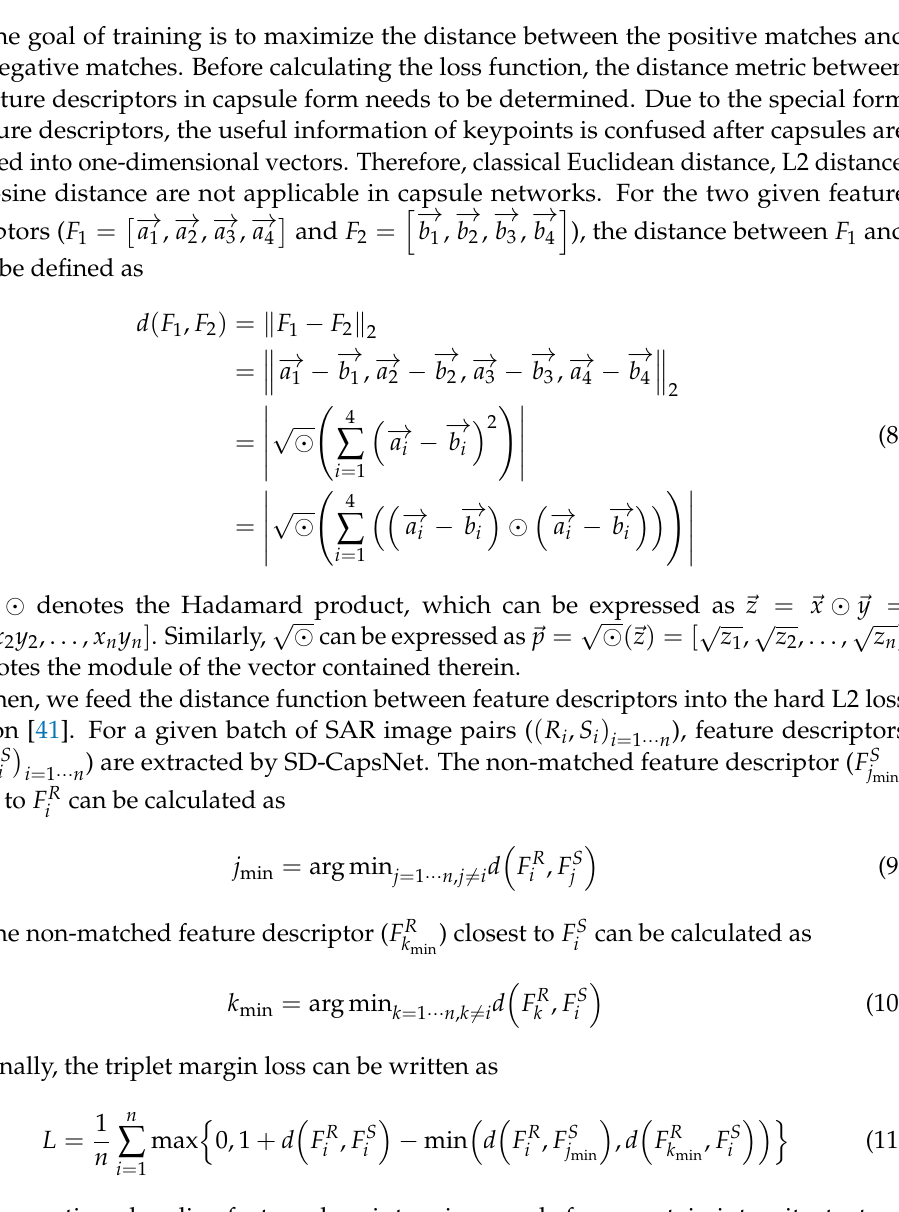
Figure 9. Illustration of the feature descriptor form. ( a ) The size of the feature descriptor. ( b ) The mathematical representation of feature